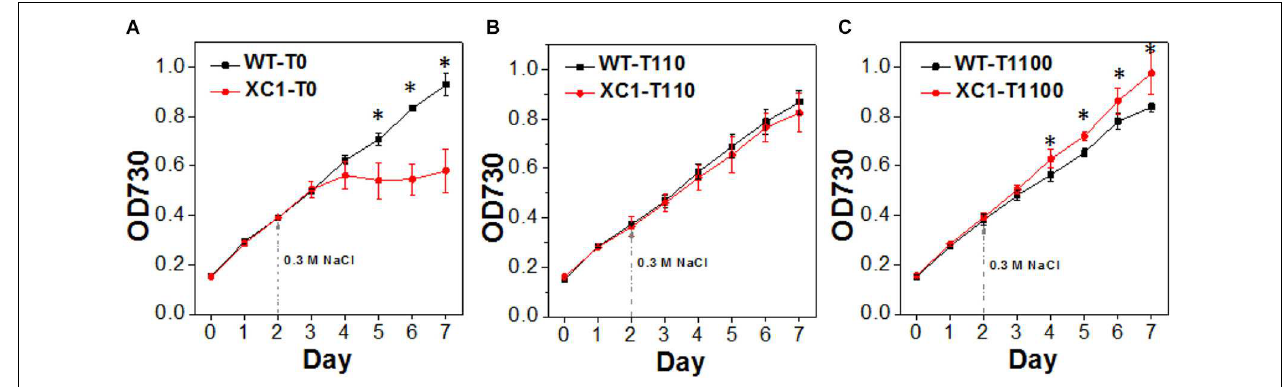
FIGURE 5 | Growths of PCC7942-WT and PCC7942-XC1 facing NaCl stress under theophylline concentrations of (A) 0 µ M, (B) 110 µ M, and (C) 1100 µ M. 0.3 M NaCl was supplemented into the culture medium in Day 2 as the arrow pointed. The OD730 data utilized are averages of measurements from at least three independent biological repeats, and standard deviation bars are also shown. Asterisksg49 indicate significant differences between the data of WT and XC1 (Student’s t -test, P < 0.05).